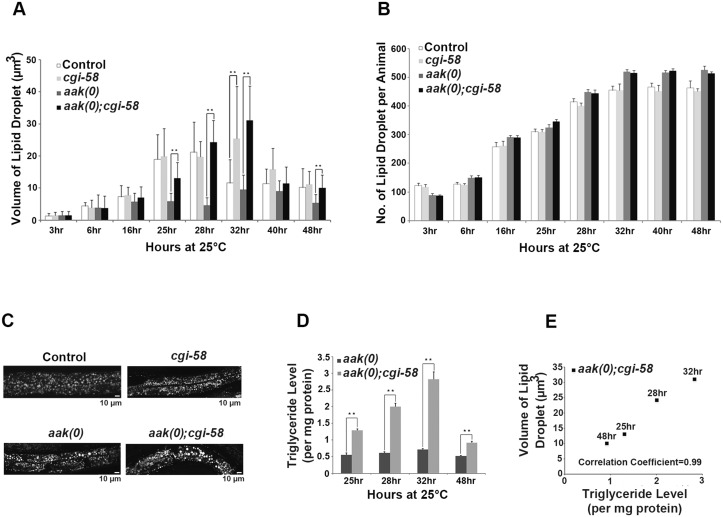
CGI-58 is essential for lipid droplet size regulation.
(A) Elimination of cgi-58 in daf-2 and daf-2; aak(0) animals led to a dramatic increase in lipid droplet size during the later part of dauer entry. C1-BODIPY-C12 -stained lipid droplets were imaged and their dimensions were quantified using the AxioVision (Zeiss) software. ** indicates statistical significance (P<0.01). Error bars indicate SD of three independent experiments. All strains carry daf-2(e1370) in (A) to (E). (B) Elimination of cgi-58 in daf-2 and daf-2; aak(0) animals had no effect on lipid droplet number. Error bars indicate SD of three independent experiments. (C) Loss of CGI-58 function caused an increase in lipid droplet size. Animals were imaged using C1-BODIPY-C12 to stain lipid droplets 32 hours after shifting to restrictive temperature (25°C) to induce dauer formation. Lipid droplet analyses performed hereafter are all at the 32 hour time point. Scale bar = 10 μm. (D)-(E) Increased lipid droplet size correlates with triglyceride content in dauer larvae that lack cgi-58. Triglyceride levels were determined in daf-2; aak(0) and daf-2; aak(0); cgi-58 animals at the later part of dauer entry. ** indicates statistical significance (P<0.01). Error bars indicate SD of three independent experiments.